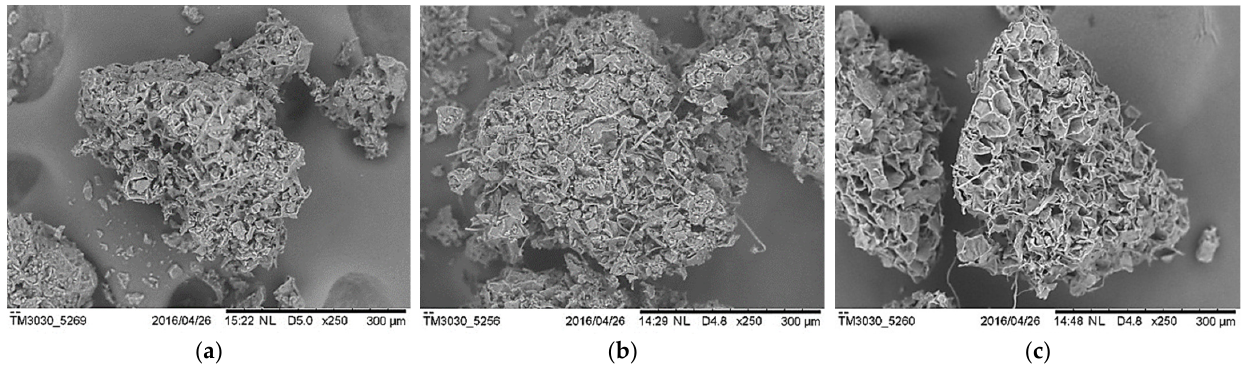
Figure 10. SEM micrograph of GCW particles of ( a ) UG, ( b ) OG and ( c ) ONG.